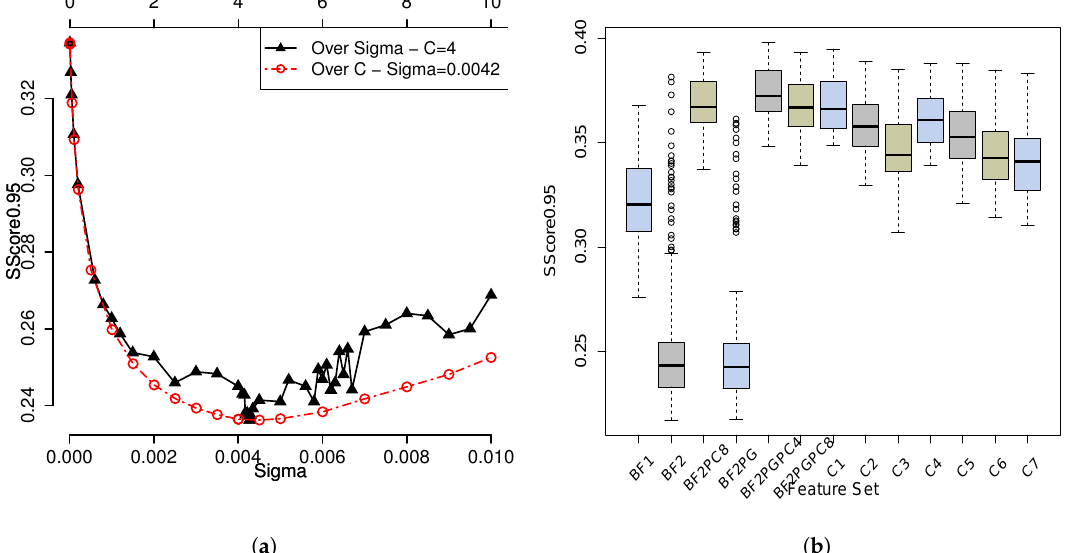
Figure 5. Kernel Quantile Regression (KQR) models. ( a ) Tuning the sigma parameter in KQR kernel function; ( b ) Box plot of skill score for different feature sets used by kernel quantile regression